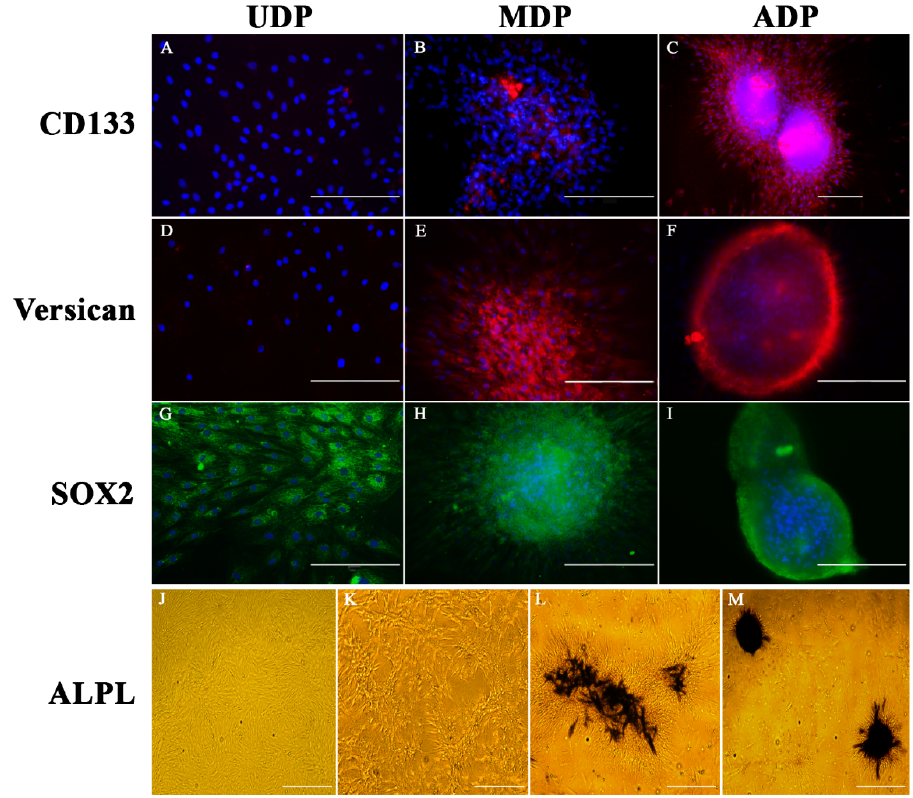
Figure 2. Identification of hair inducing capability of cultured DP cells. Bar = 200 µ m. Comparison of immunofluorescence staining of CD133 ( A – C ), versican ( D – F ), SOX2 ( G – I ) and alkaline phosphatase (ALPL, J – M ) on fixed 2D patterned DP cells (UDP), the re-aggregating DP cells (MDP) and restored 3D patterned DP cells (ADP). ( A ) UDP do not express CD133 (red) and DAPI (blue) marks all cell nuclei. ( B ) CD133 begins to express in MDP, but the expression intensity is weak (red). ( C ) ADP show strong CD133 expression intensity. ( D ) UDP do not express versican (red) and DAPI (blue) marks all cell nuclei. ( E ) Versican begins to express in MDP and the expression intensity is strong. ( F ) ADP continually show strong versican expression intensity. ( G ) UDP have strong expression intensity of SOX2 (green) and DAPI (blue) marks all cell nuclei. ( H ) The expression intensity of SOX2 (green) keeps strong in MDP. ( I ) ADP continually keep strong SOX2 expression (green). ( J – M ): bar = 500 µ m. Comparison of Alkaline phosphatase (ALPL) staining during the process of ADP formation. ( J ) UDP do not show the ALPL staining. ( K ) DP cells do not express ALPL when they begin to aggregate. ( L ) MDP express strong expression of ALPL. ( M ) The ALPL expression reaches highest intensity in